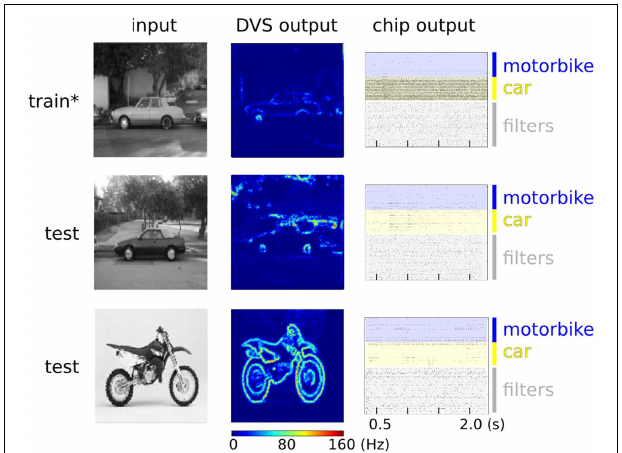
FIGURE 13 | Spiking activity of the hardware neurons during the training (upper panel) and testing phase (middle and lower panels). Left column : examples of raw images from the Caltech 101 database. Middle column : heat map of the DVS spiking activity, where each pixel color represents the pixel’s mean firing rate. Right column : raster plots of the ROLLS neuromorphic processor neurons. The star on the top panel label indicates that during the training phase an additional excitatory “teacher” signal was used to stimulate the “car” output neurons to induce plasticity. During testing no teacher signal is provided and only the excitatory currents from the input synapses drive the classifier activities. The average firing rates of the output layer for “motorbike” and “car” neuron pools are 6.0 Hz and 80.9 Hz during training. During testing with a “car” image they are 7.1 Hz and 11.1 Hz. During testing with a “motorbike” image they are 7.4 Hz and 4.9